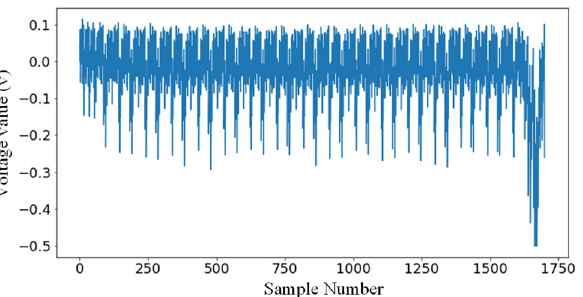
Figure 6. Waveform of the first round traces of the ATXMEGA128D4 implementation of TintAES-128 (AES_ XMEGA).